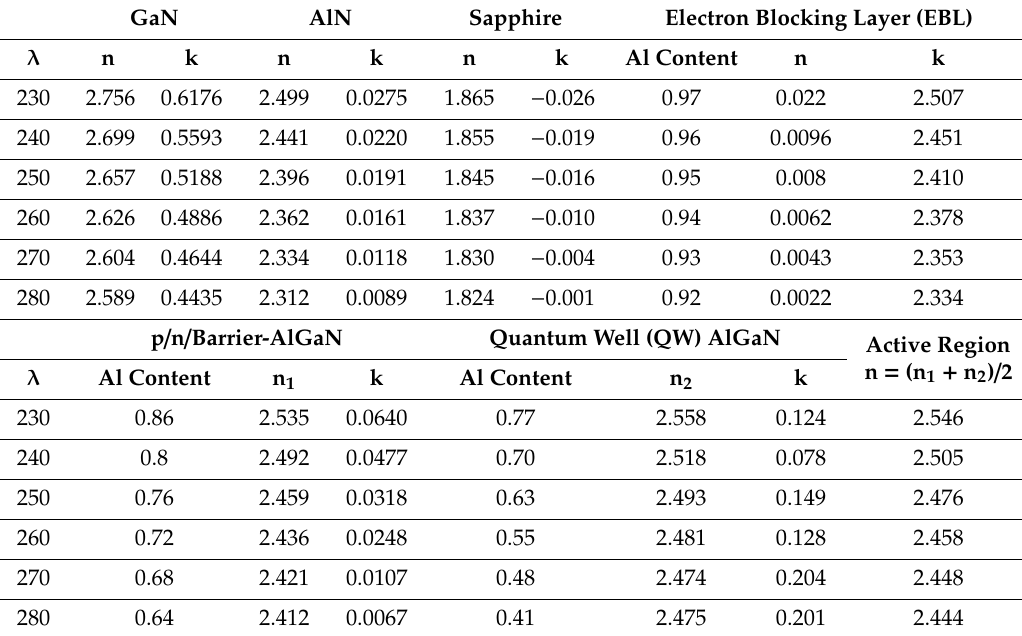
Table 2. Refractive index (n) and extinction coe ffi cient (k) of the materials [36].